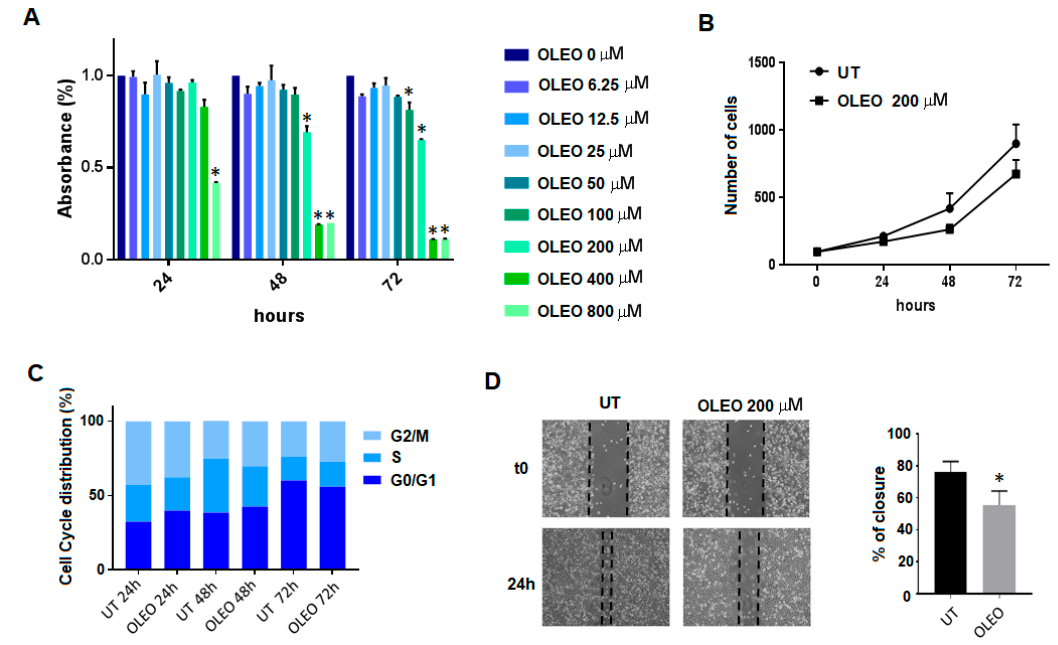
Figure 1. Effects of Ole-enriched leaf extract (OLEO) on A375 melanoma cells. ( a ) Dose-time response evaluated by MTT assay. Significance is indicated with *; ( b ) Cell growth of A375 human melanoma cells treated with OLEO 200 μ M; ( c ) Cell cycle distribution analyzed using FACS; ( d ) E ff ect of OLEO 200 μ M on the motility of A375 cells evaluated by scratch wound healing assay. Significance is indicated with *.